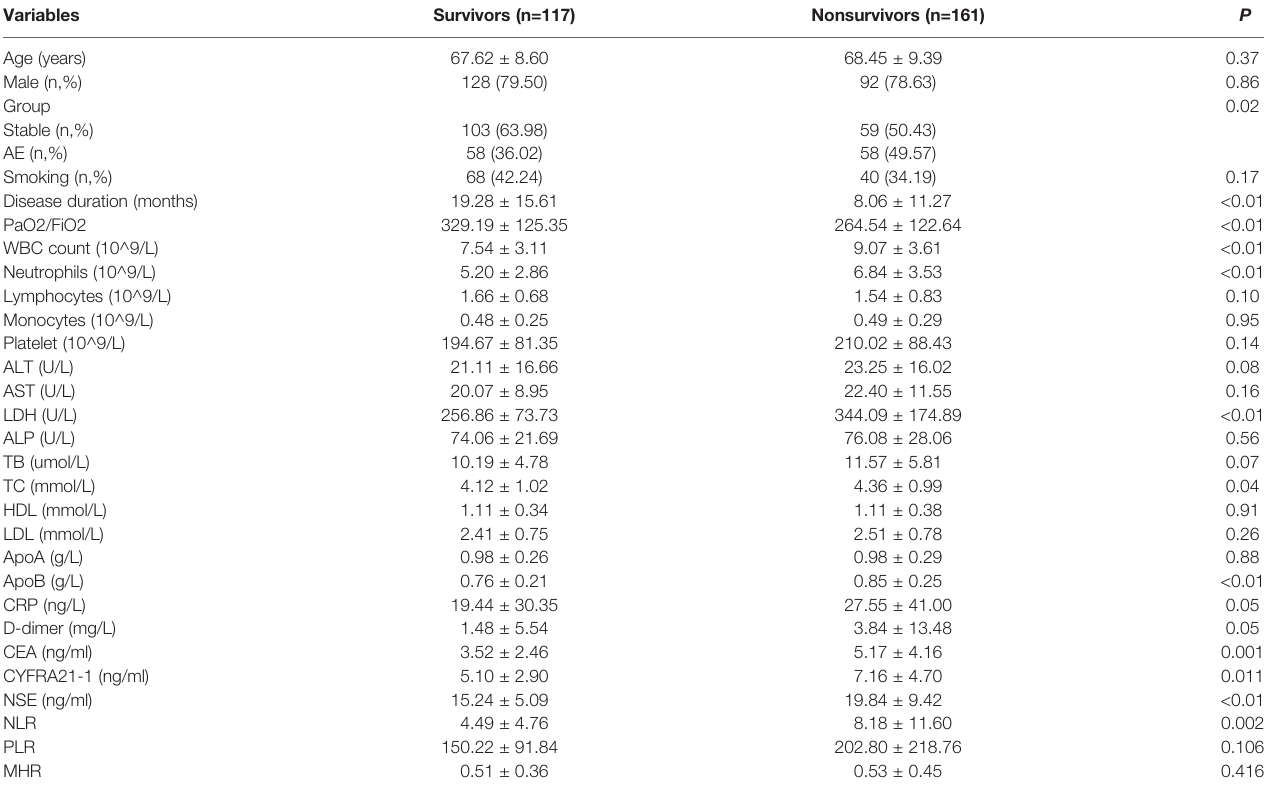
TABLE 1 | Baseline characteristics of the total cohort.